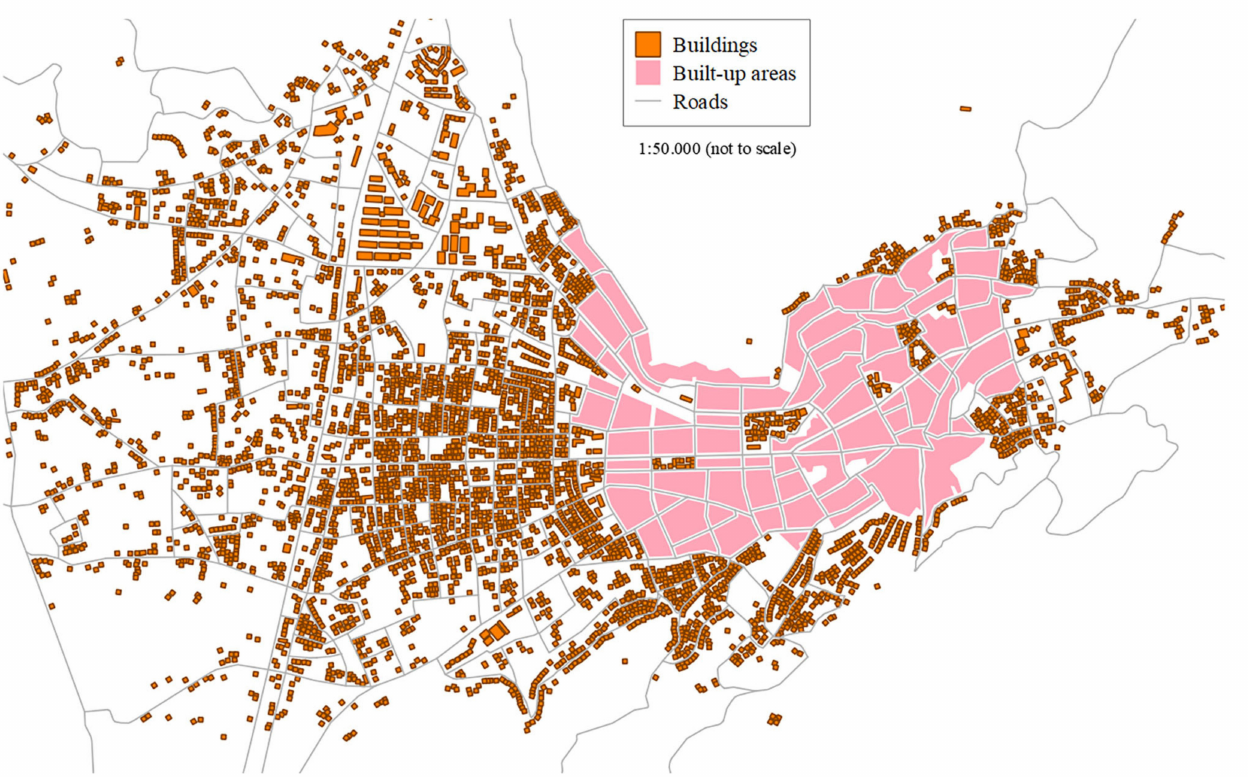
Figure A2. 1:50k topographic map data of the study area after individual generalization.